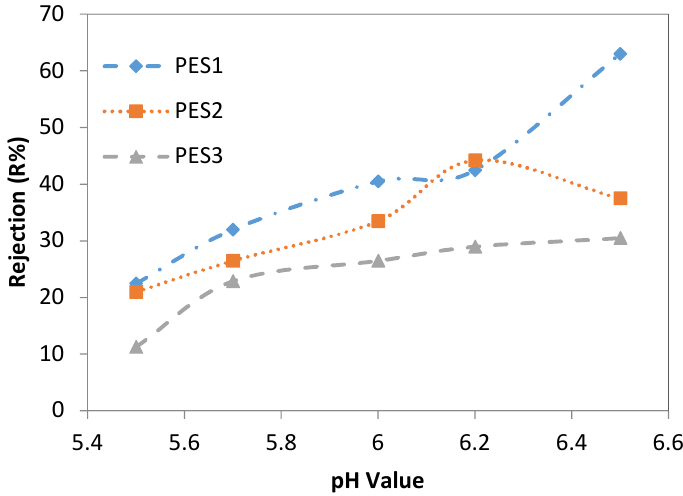
Figure 6. E ff ect of feed pH on Cd 2 + rejection of PES1, PES2, and PES3 membranes (experimental conditions: Cd 2 + concentration of 100 ppm, and transmembrane pressure of 1 Figure 6. Effect of feed pH on Cd 2+ rejection of PES1, PES2, and PES3 membranes (experimental conditions: Cd 2+ concentration of 100 ppm, and transmembrane pressure of 1 bar).